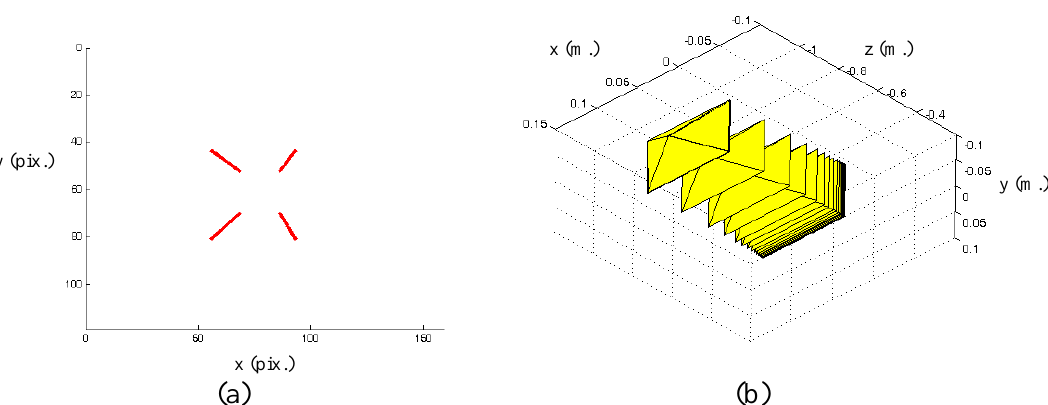
Figure 13. Trajectory during the visual servoing task. (a) Trajectory of the image features. (b) Trajectory of the eye-in-hand camera. Experiment 2.